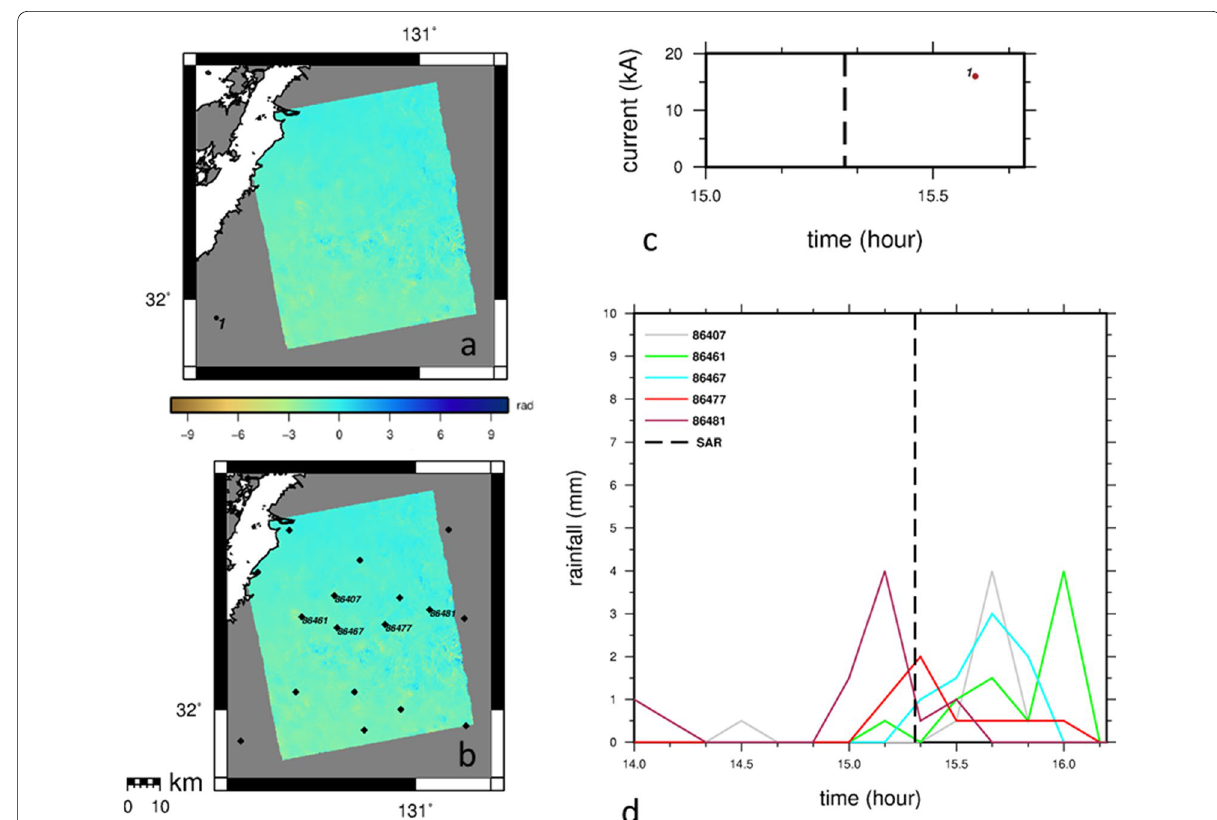
Fig. 5 �φ dispersive of SSM on Kyushu 20180731_20180828. a Overlaid by lightning location. b Overlaid by the AMeDAS station distribution. The temporal relations of ( c ) the lightning and ( d ) 10 min rainfall with the SAR observation time that is indicated with the black dashed